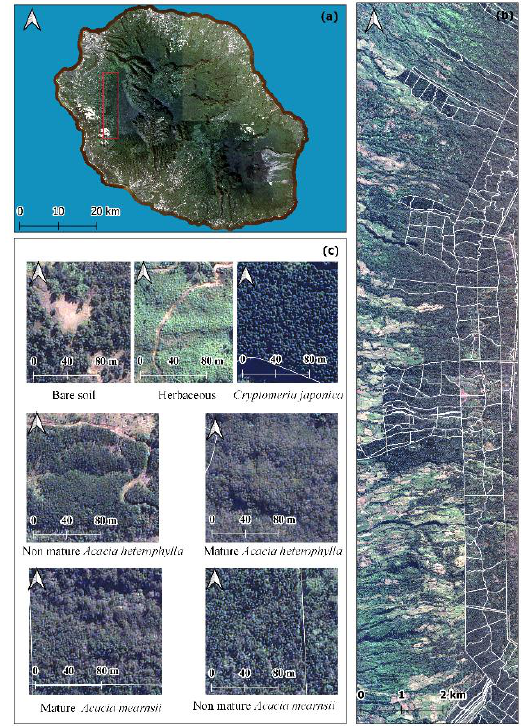
Figure 1. Study area, Western Highlands region, Reunion Island (a) Location of the study area (b) Pleiades image of the study area and delineation of public forest plots (in white) (c) Main land cover types and forest stands